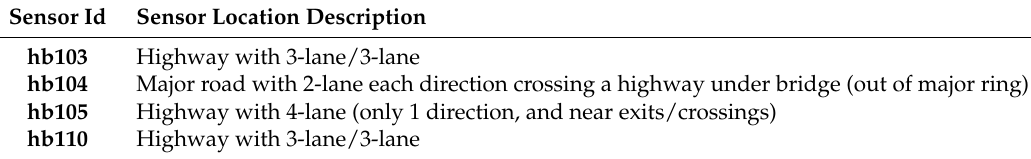
Table A2. Sensor locations description for suburban environment. X-lane/Y-lane road stands for a two-way road that has X lanes in one sense and Y lanes in the opposite sense. X-lane road stands for a street with X lanes in the same